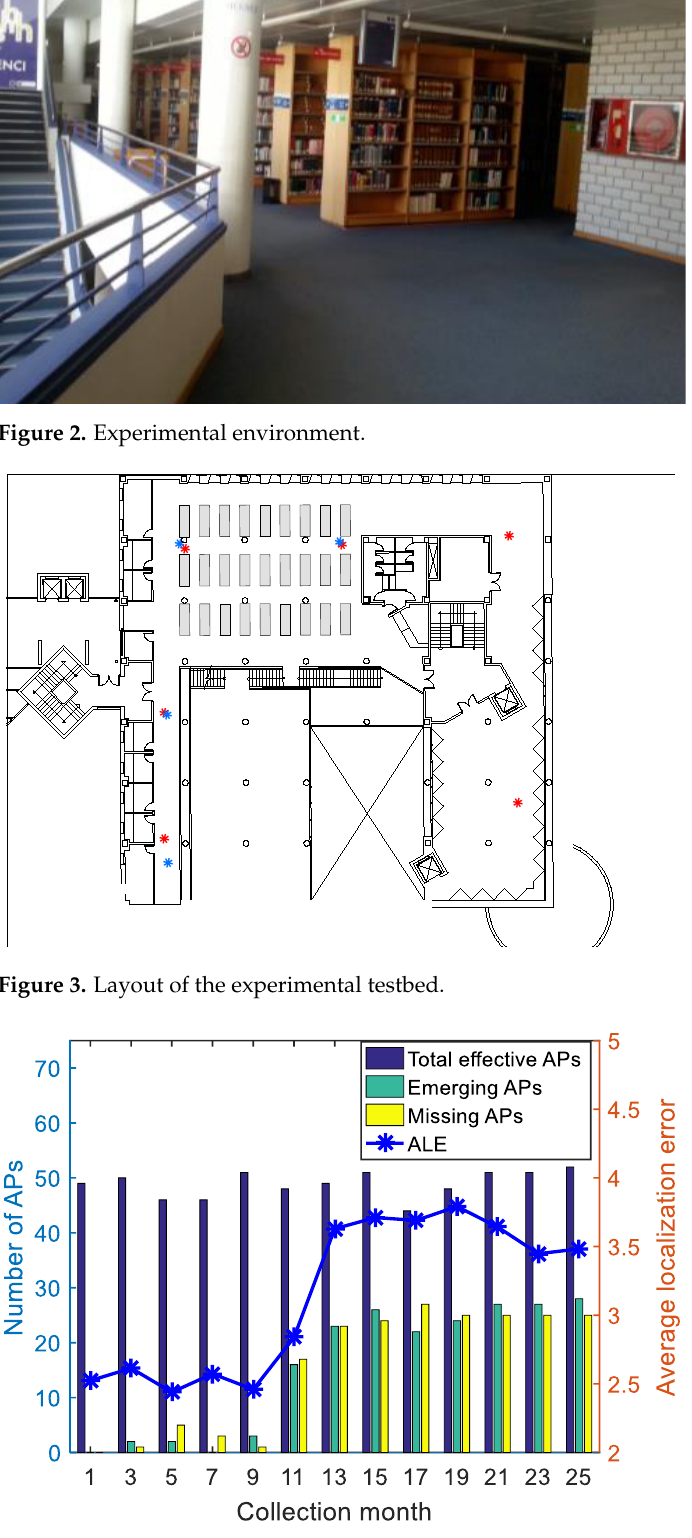
Figure 4. AP variations during the 25